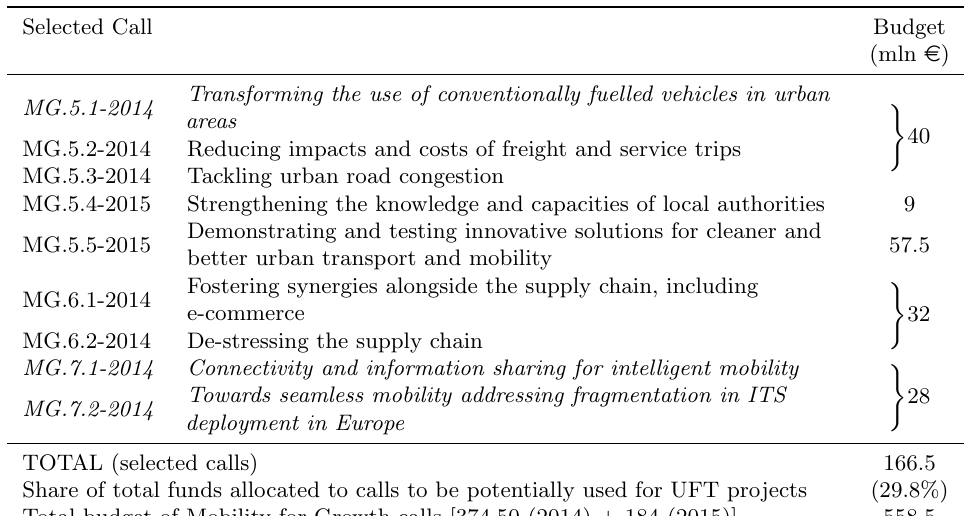
Table 3: H2020 Work Programme 2014-2015: a budget